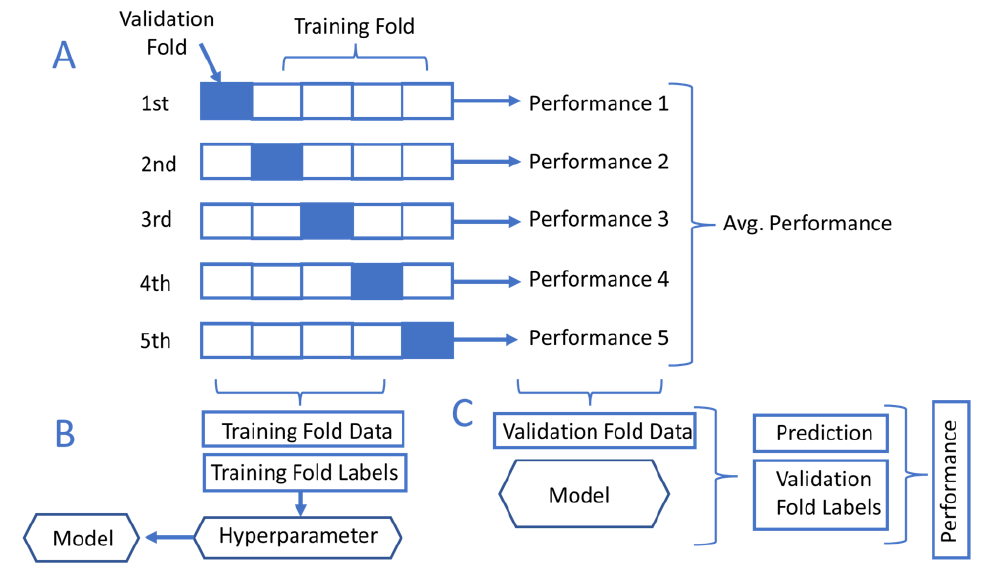
Figure 5. K -fold cross-validation process. ( A ) The K iterations of the cross-validation. ( B ) The training fold data and labels. ( C ) Evaluating model performance during the validation fold data